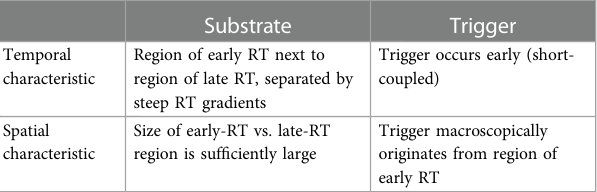
TABLE 1 The spatiotemporal characteristics of trigger-substrate interaction leading to VF in hearts with repolarization abnormalities